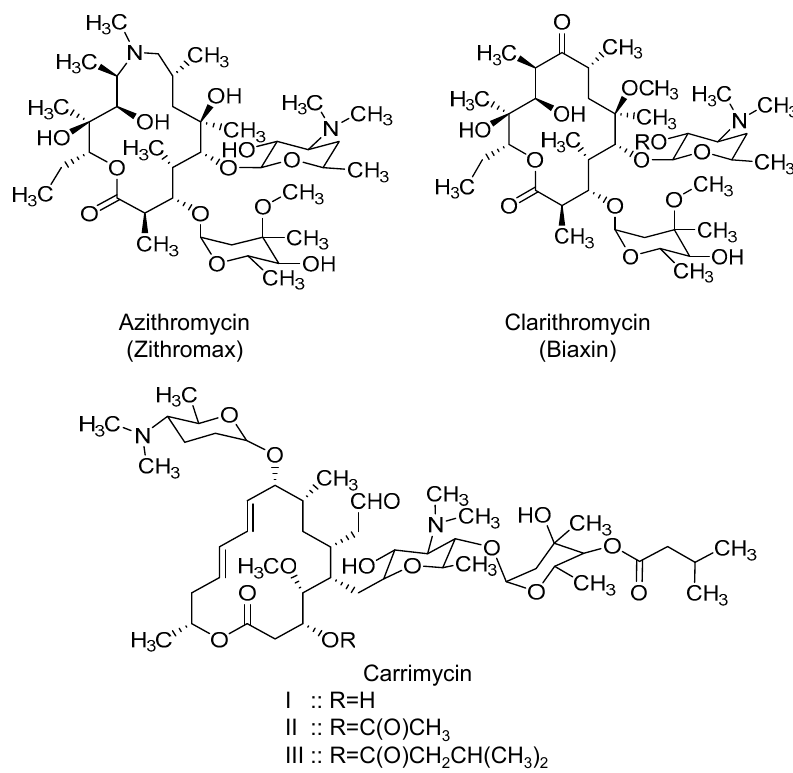
Figure 7. The chemical structures of three macrolides that are currently being evaluated in clinical trials for the treatment of COVID-19 patients. The macrolides also exhibit anti-inflammatory/ immunomodulatory effects.